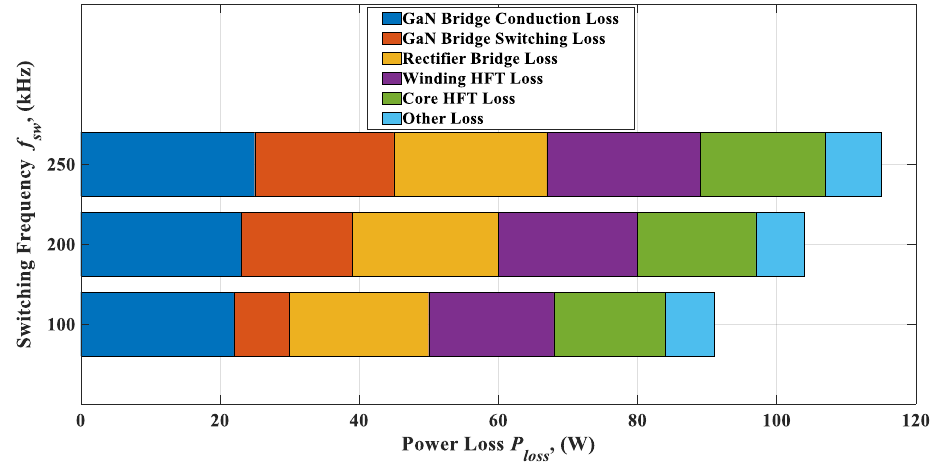
Figure 13. Detailed loss distribution of the proposed converter at 5 kW and different switching